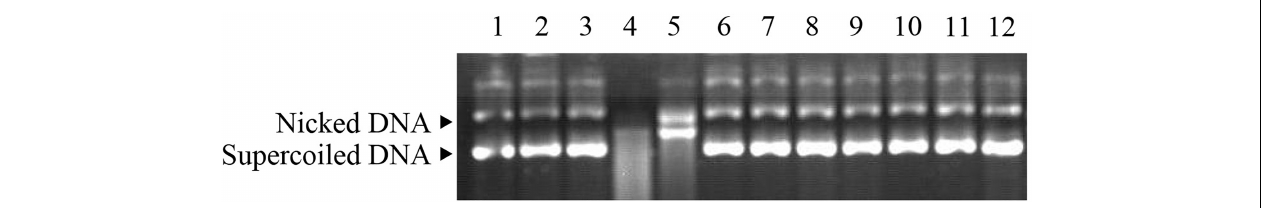
FIGURE 10 | MCO assay demonstrating the antioxidant properties of Ps-Grx3. Lane 1, pUC19 plasmid; lane 2, pUC19 + FeCl 3 ; lane 3, pUC19 + DTT; lane 4, pUC19 +